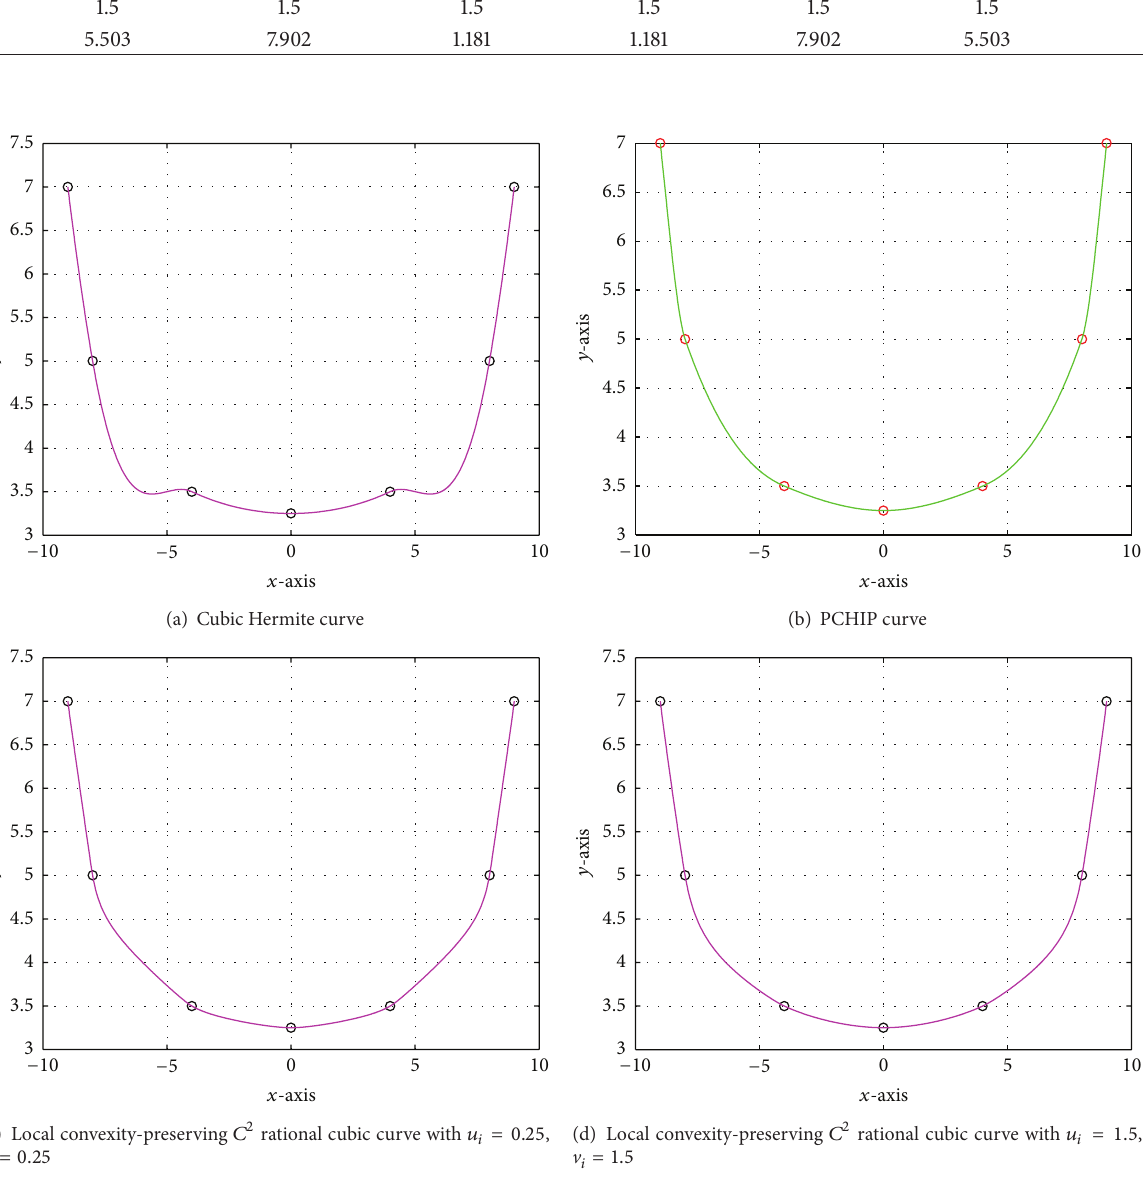
Figure 3: Convex and nonconvex curves through given convex data